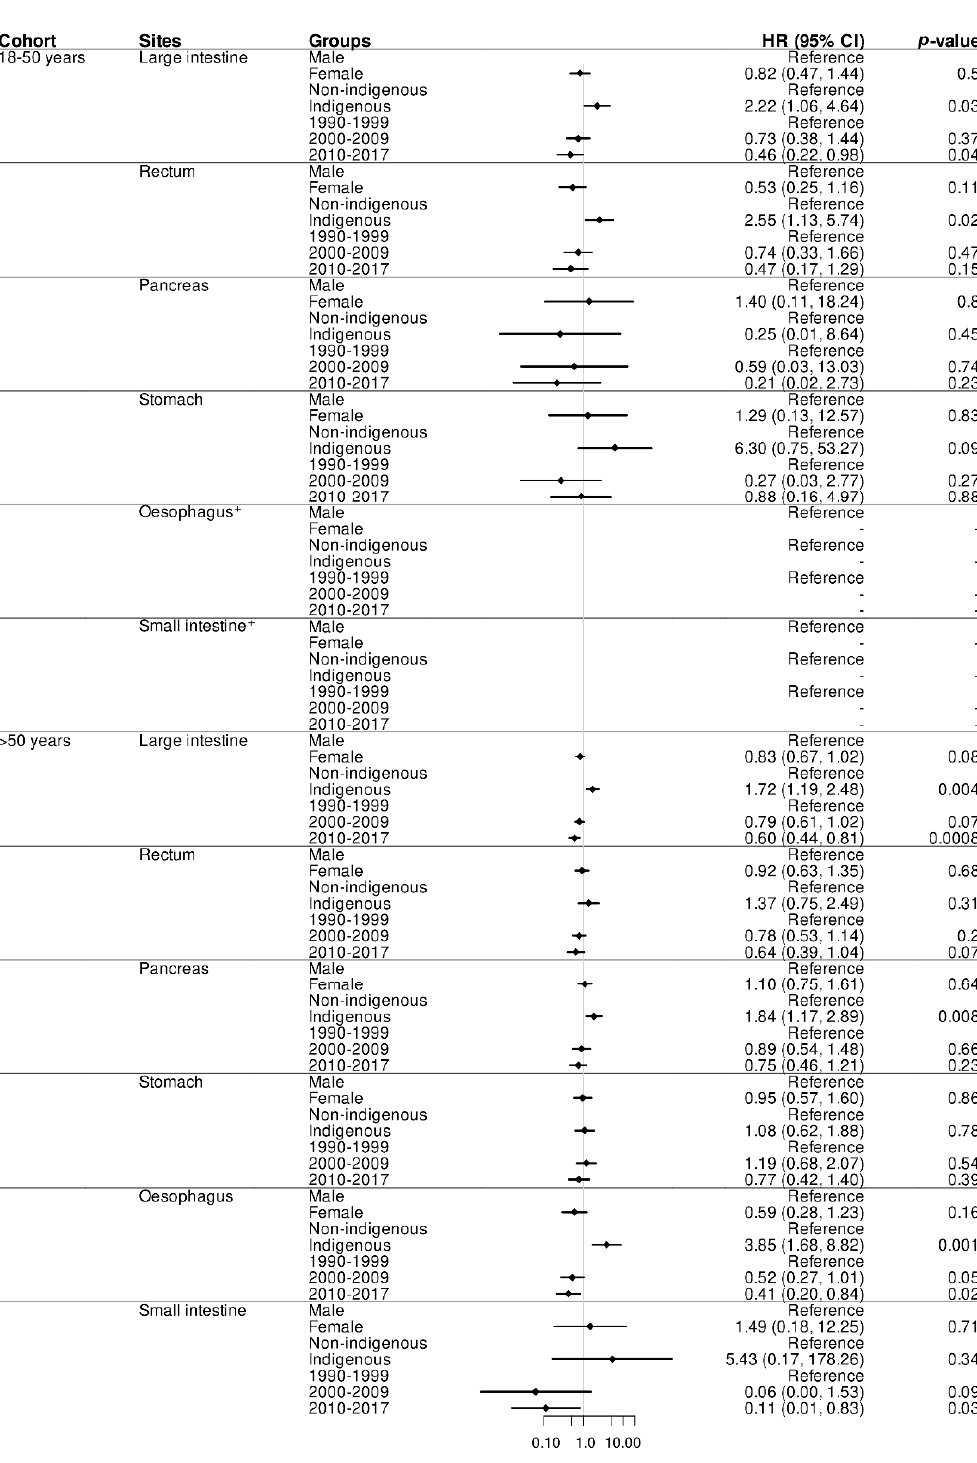
Figure 2. Hazard ratios (HR) and 95% CI (Cox proportional hazard model) for Indigenous status, sex, and era by primary sites between two age groups ( n = 1608). + Reliable estimates of HR (95% CI) cannot be obtained for Oesophagus and Small intestine in 18–50 years due to small sample